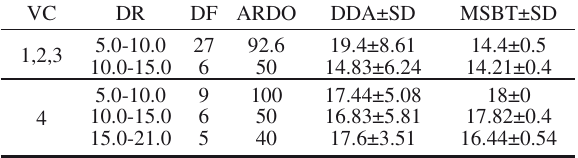
Table 2. – O. vulgaris den data in the Rodas inlet. VC, visual census number; DR, depth range (m); DF, number of dens found; ARDO,